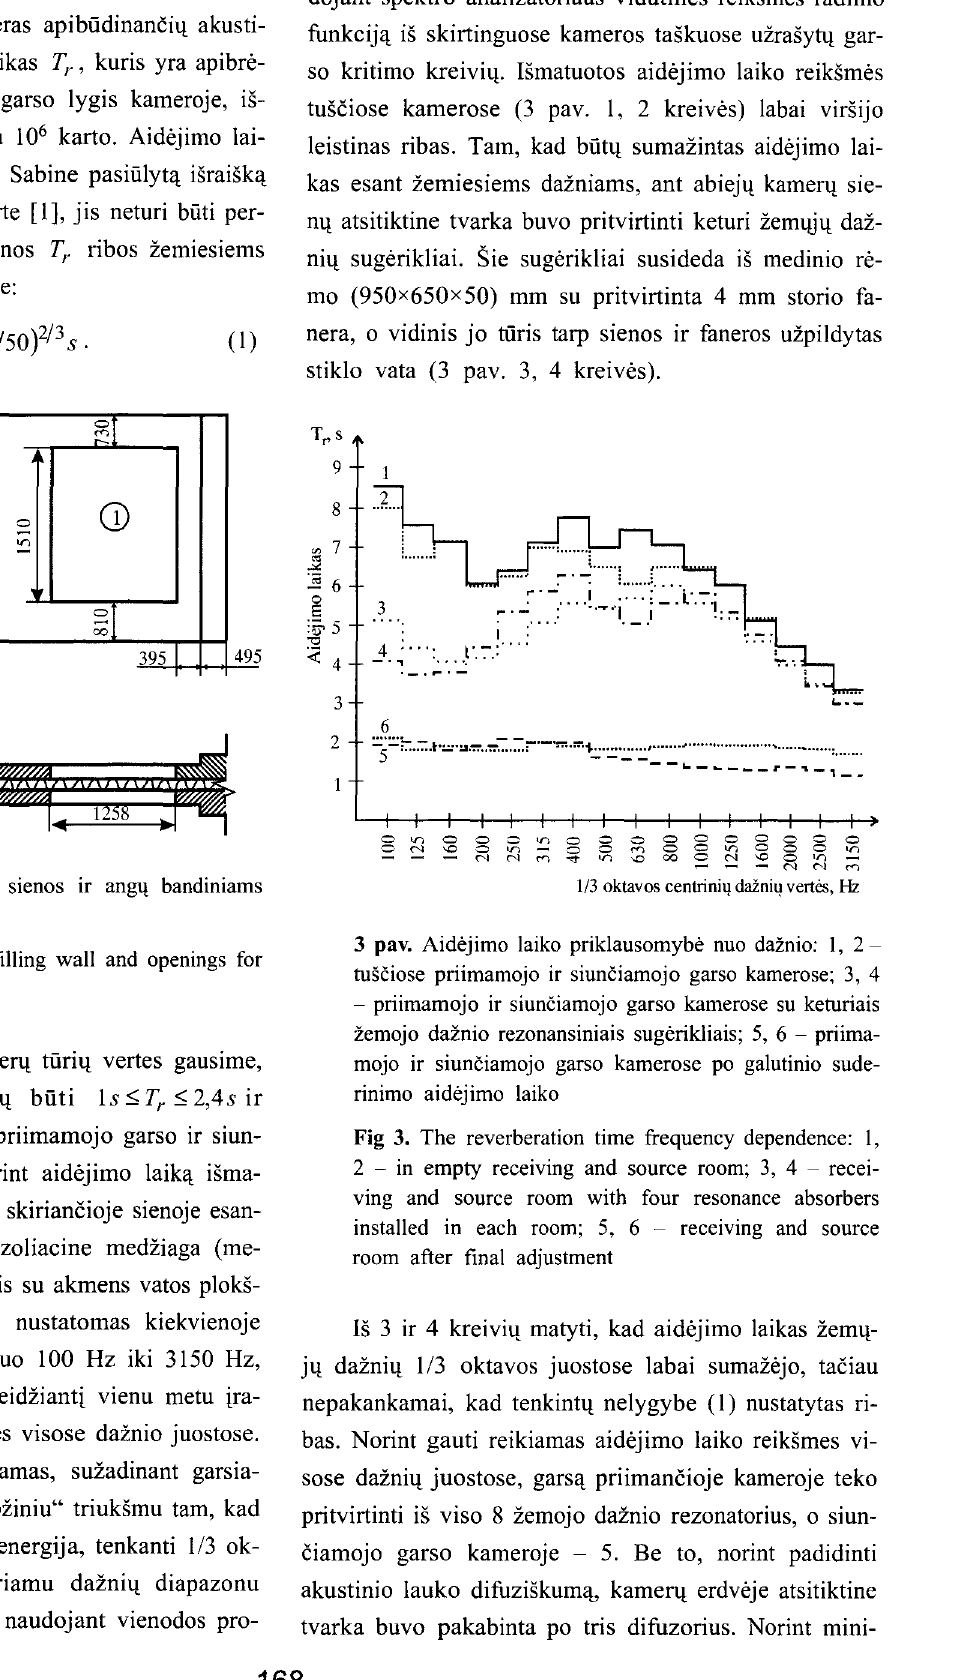
Fig 3. The reverberation time frequency dependence: I, 2 - in empty receiving and source room; 3, 4 - recei ving and source room with four resonance absorbers installed in each room; 5, 6 - receiving and